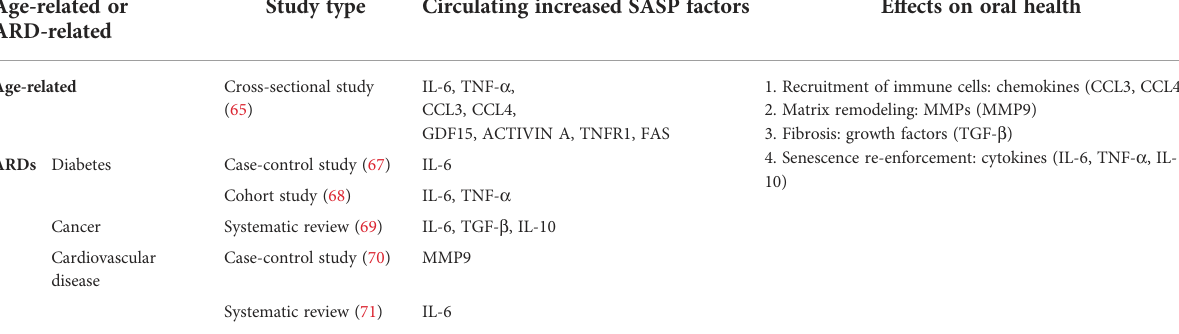
TABLE 3 Age-related versus ARD-related circulating SASP and effects on oral health.